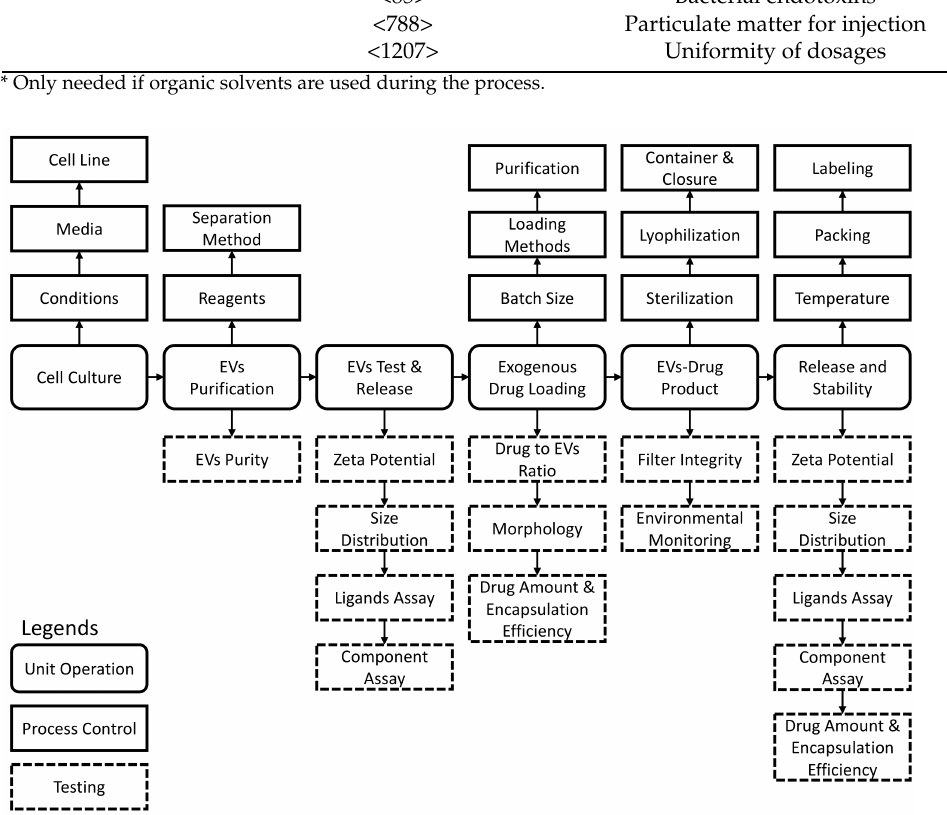
Figure 4. A conceptual process flow chart describing the unit operations for EV drug